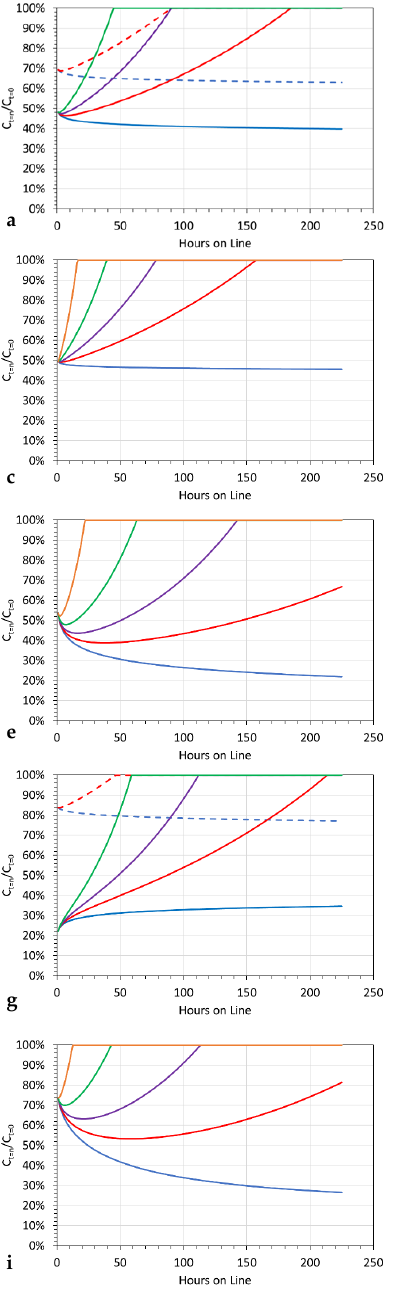
Figure 17. Expected values of C t = n / C t = 0 for different polymers, where C = salinity, versus time. [ d ] = 1: blue; [ d ] = 1.005: red; [ d ] = 1.01: purple; [ d ] = 1.02: green; [ d ] = 1.05: orange; Reactor Process flow: Figure 13. ( a ), Fe-Ca polymer, Table 1, Trial 1; dashed lines = 1.4 g FeSO 4 L − 1 ; solid lines = 2.8 g FeSO 4 L − 1 . [ R r ] = 0%. ( b ), Fe-Ca polymer Trial 2 (Table 1); dashed lines = 1.4 g FeSO 4 L − 1 ; solid lines = 7 g FeSO 4 L − 1 . [ R r ] = 0%. ( c ), Fe-Ca- urea polymer, Trial 3, Table 1; [ R r ] = 0%. ( d ), Fe-Ca-Mn-Formic Acid polymer Trial 4 (Table 1); [ R r ] = 90%; ( e ), Fe-Ca-Mn-formic acid polymer Trial 5 (Table 1); [ R r ] = 90%; ( f ), Fe-Ca-Zn-gallic acid polymer Trial 6 (Table 1); dashed lines = 0.8 g FeSO 4 L − 1 ; solid lines = 8 g FeSO 4 L − 1 . [ R r ] = 90%. ( g ), Fe-Zn-urea polymer, Trial 7, Table 1; dashed lines = 1.42 g FeSO 4 L − 1 ; solid lines = 14.2 g FeSO 4 L − 1 ; [ R r ] = 90%; ( h ), Fe-Ca-Mn-Mg-formic acid polymer; Trial 8, Table 1; [ R r ] = 90%; ( i ), Fe-Ca-Mn-K-formic acid polymer; Trial 9, Table 1; [ R r ] = 90%; ( j ), Fe-Ca-Zn-tartaric acid polymer. Trial 10, Table 1; [ R r ] =